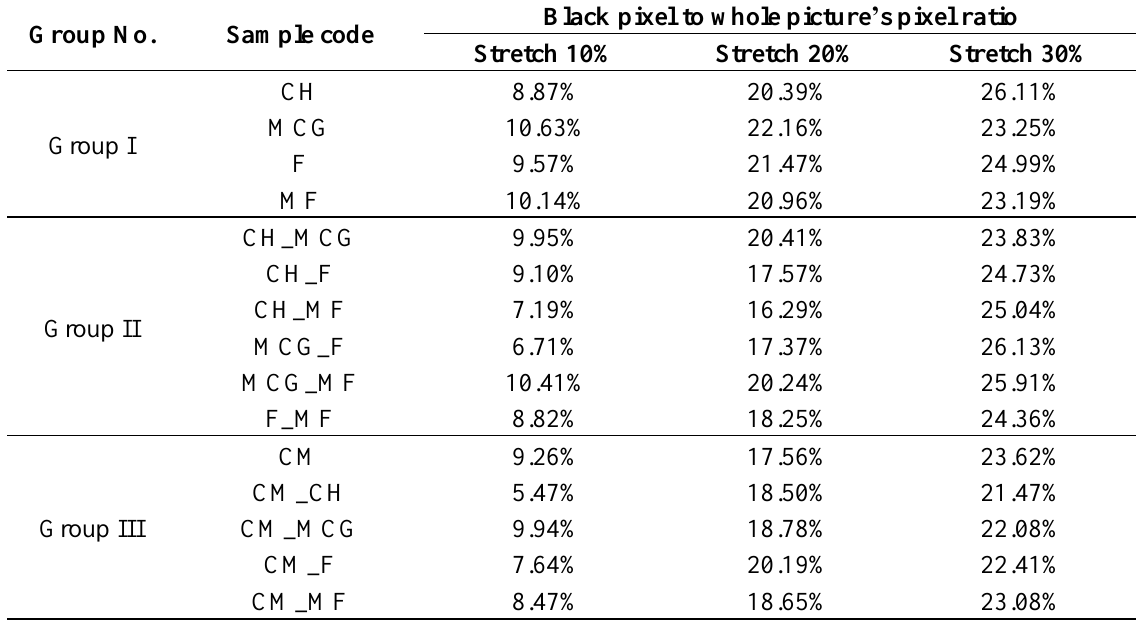
Table 6. Black pixel to whole picture’s pixel ratio.